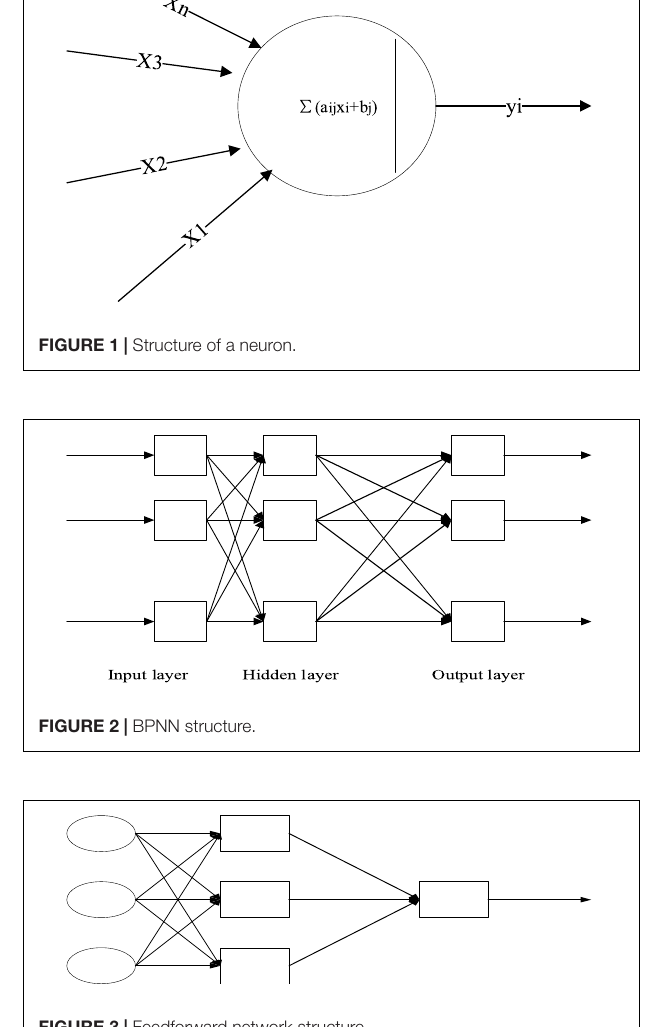
FIGURE 3 | Feedforward network